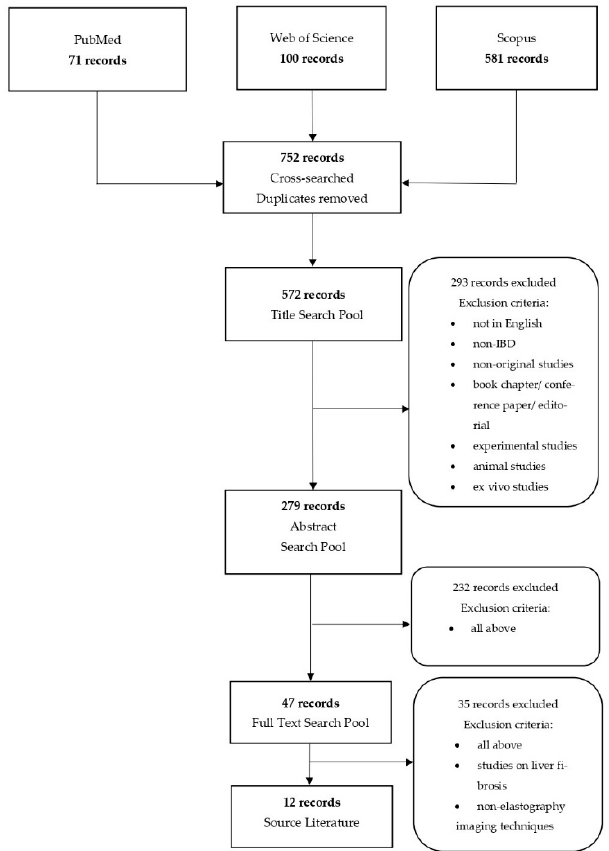
Figure 1. Flowchart presenting the selection process.